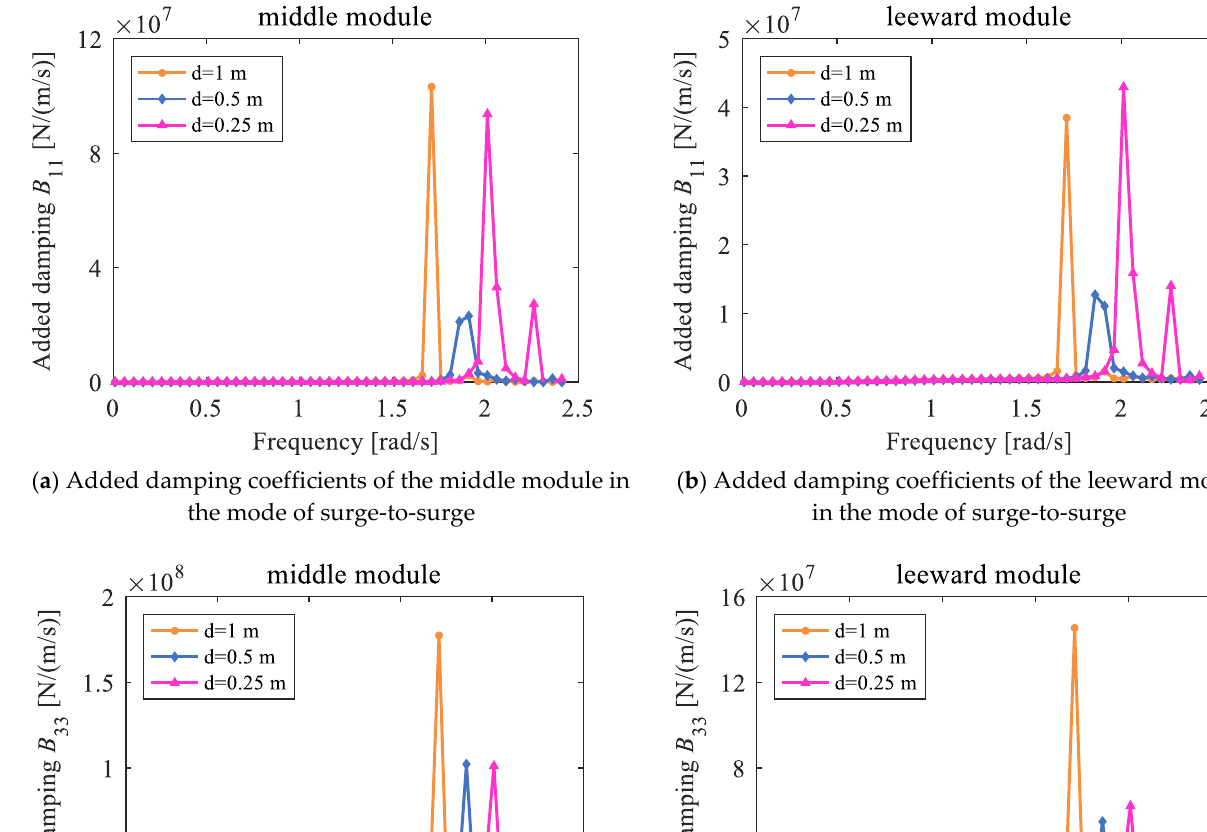
From the above part, it is easy to illustrate that the hydrodynamic resonance phe-